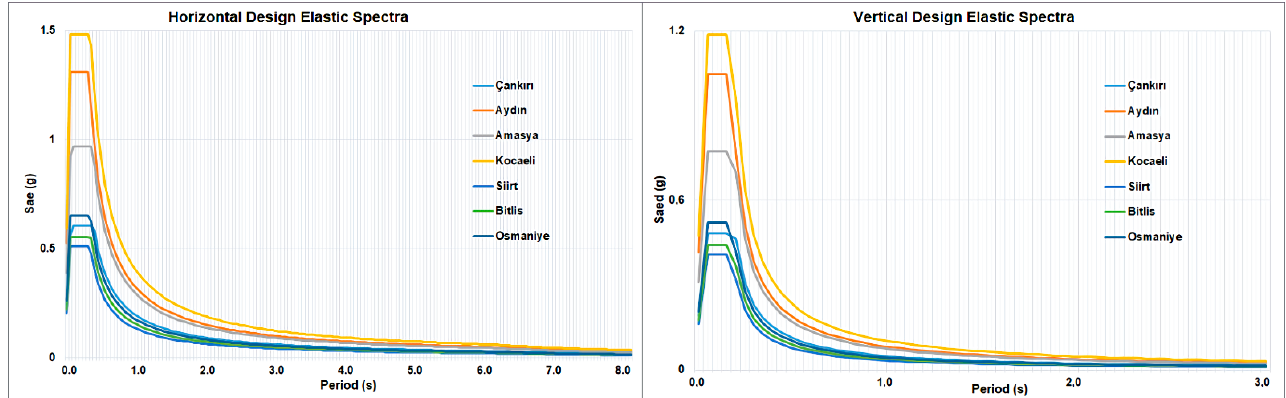
Figure 15. Comparison of horizontal and vertical elastic design spectra